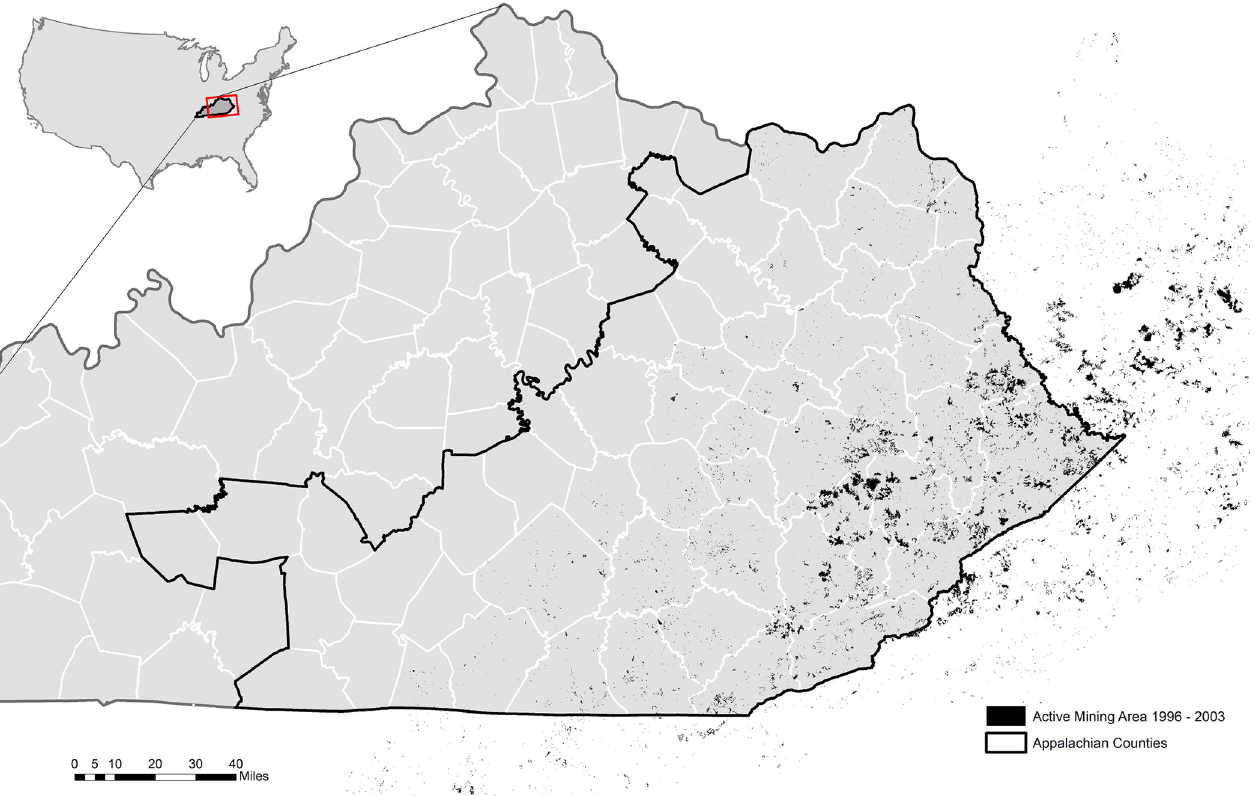
Fig 1. Cumulative active mountain top removal mining areas from 1996–2003 overlaying Kentucky Appalachian designated counties.